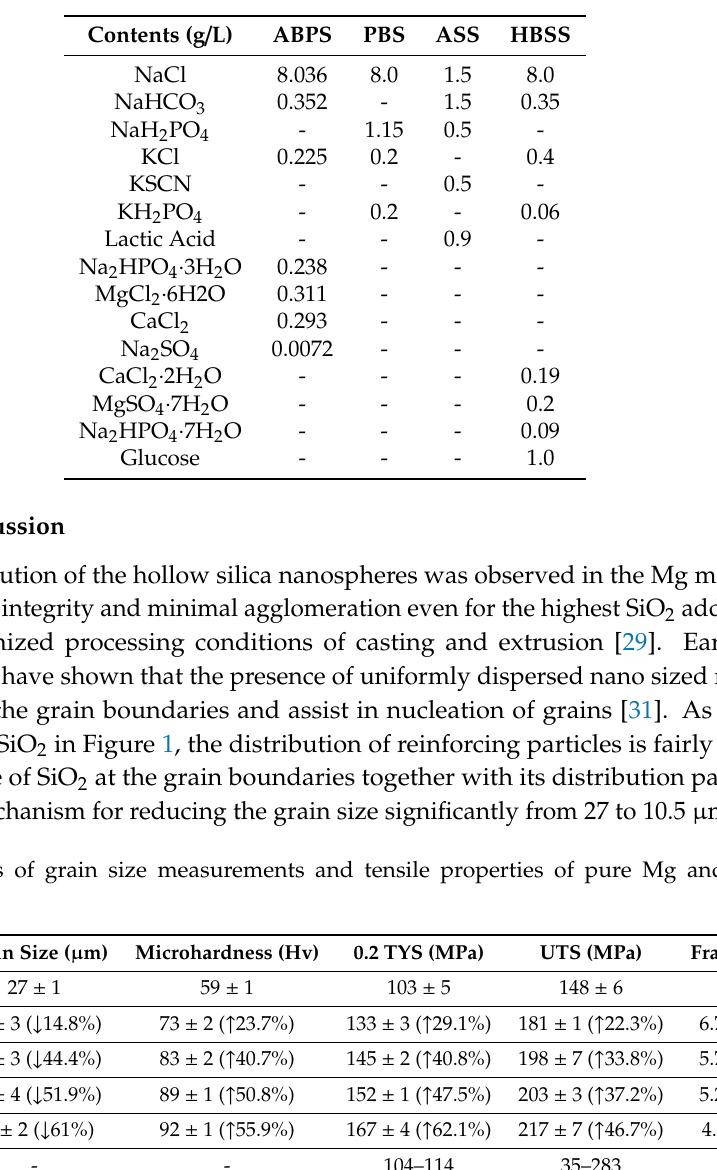
Table 1. Chemical compositions of di ff erent simulated body fluids.